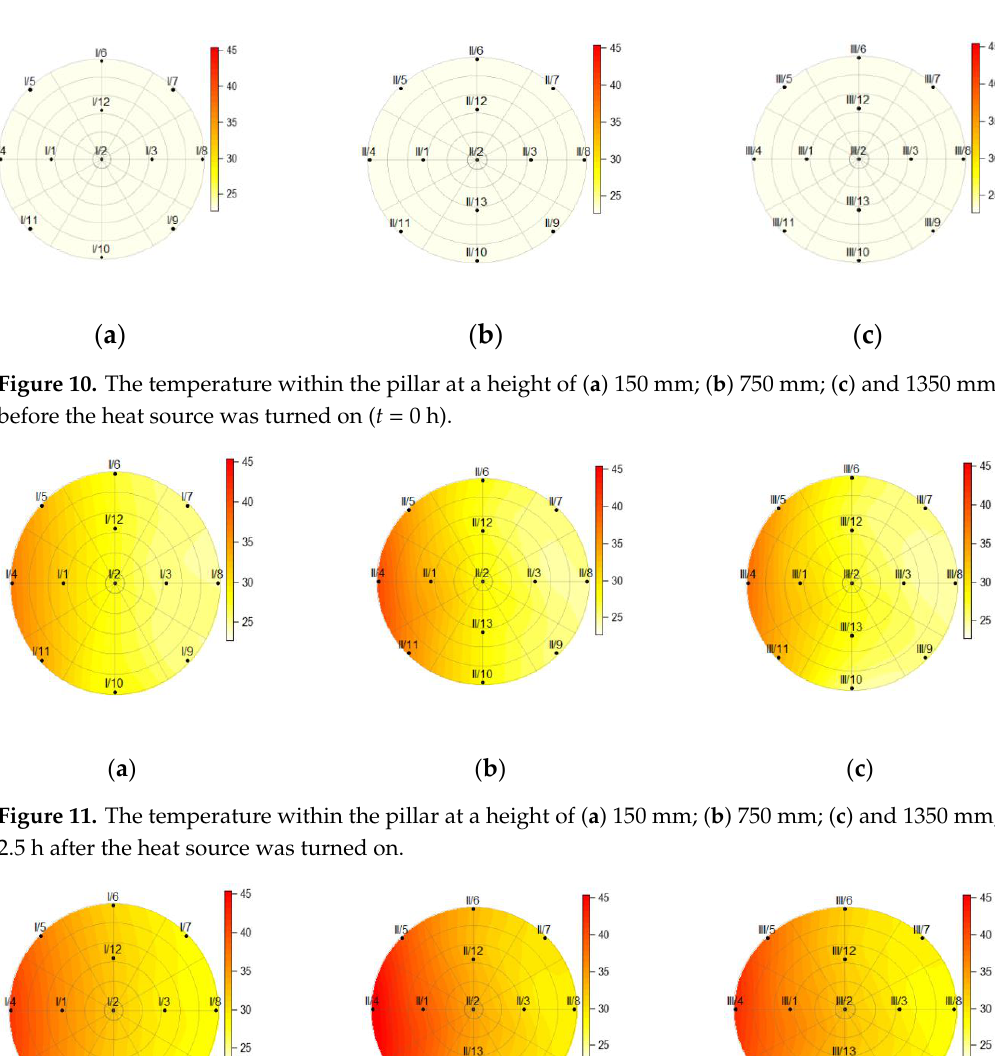
Figure 11. The temperature within the pillar at a height of ( a ) 150 mm; ( b ) 750 mm; ( c ) and 1350 mm, 2.5 h after the heat source was turned on.